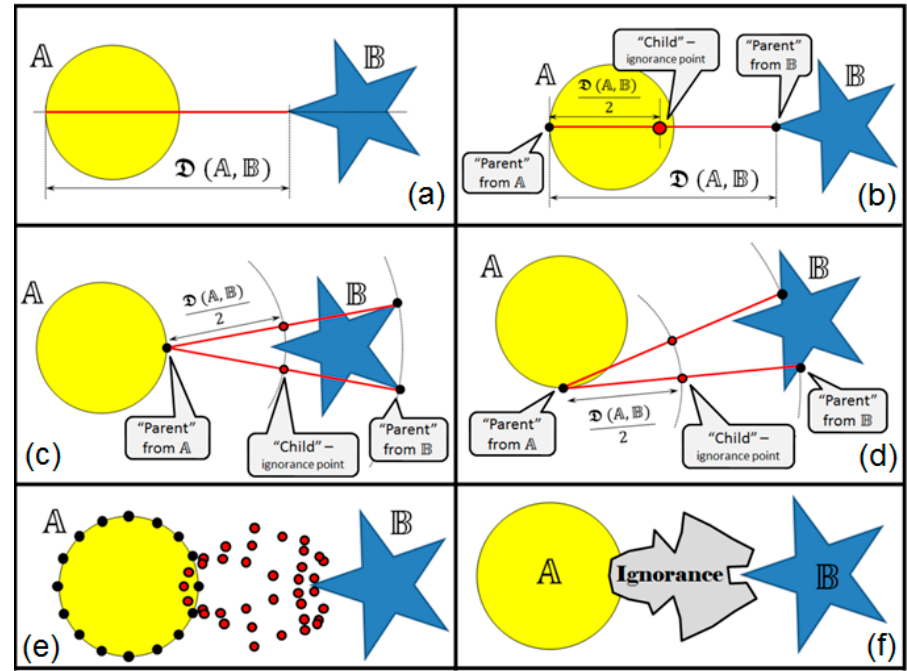
Figure 6. Illustration of the ignorance zone discovery with the Manifold Distance: ( a ) Computed Manifold Distance; ( b ) Nomination of valid “parents”; ( c ) and ( d ) discovery of a “child” for each pair of “parents”; ( e ) all the discovered children are shown; ( f ) discovered ignorance boundary and corresponding ignorance zone is shown. One can see that the shape of such zone does not depend much on near-neighbors from both manifolds but more on overall shapes of the mani- folds.